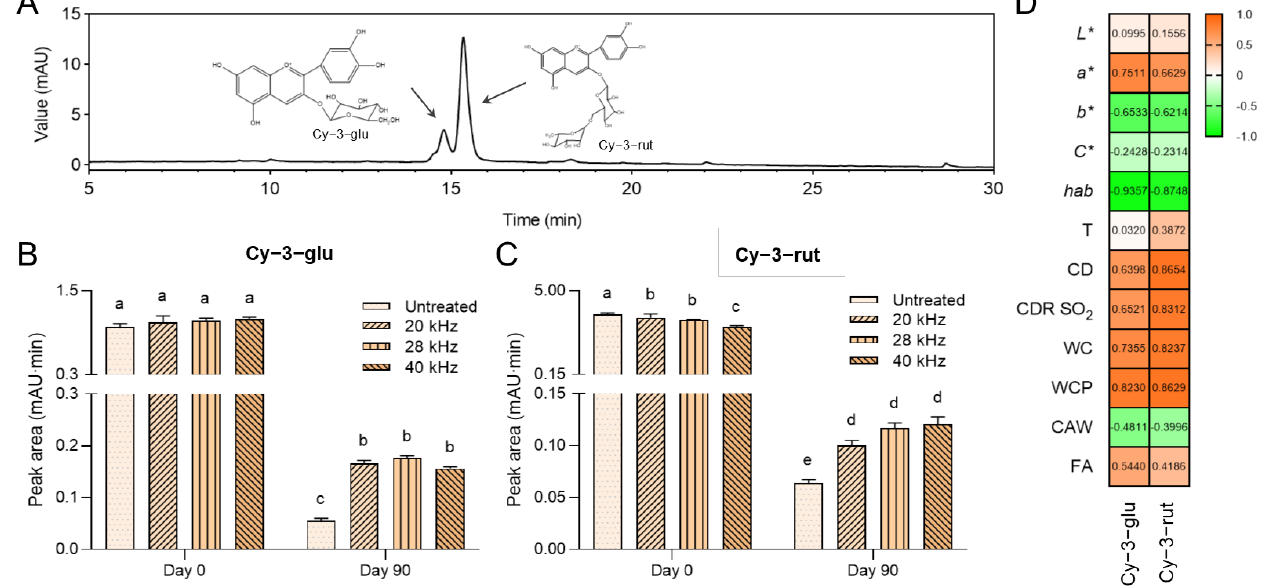
Figure 4. Anthocyanin changes during wine aging. ( A ) HPLC chromatogram of freshly fermented Sanhua plum wine at 520 nm. Two primary anthocyanins were identified as indicated. ( B ) Peak area of Cy-3-glu at 520 nm with different ultrasonic treatments. ( C ) Peak area of Cy-3-rut at 520 nm with different ultrasonic treatment. ( D ) The correlation between anthocyanins and color parameters. The number inside of the box indicates the coefficient of association. Different letters indicate a significant difference between the groups.